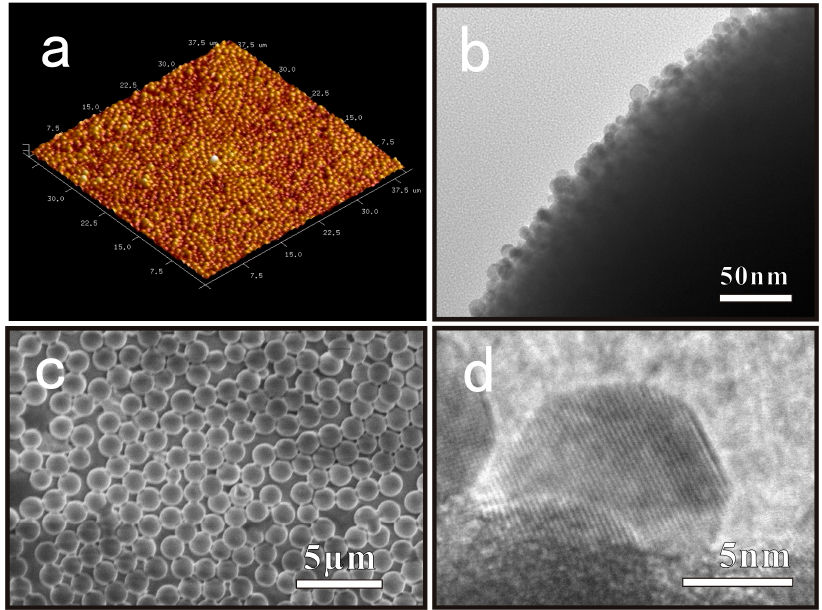
Figure 3. Images of PDMS-SMs-AgNPs. ( a ) The AFM image of SMs with AgNPs formed on the surface of PDMS; ( b ) The HRTEM images of AgNPs supported on SMs; ( c ) SEM images of SMs with AgNPs loading on the surface of PDMS; ( d ) The interplanar spacing of the lattice fringes of AgNPs.